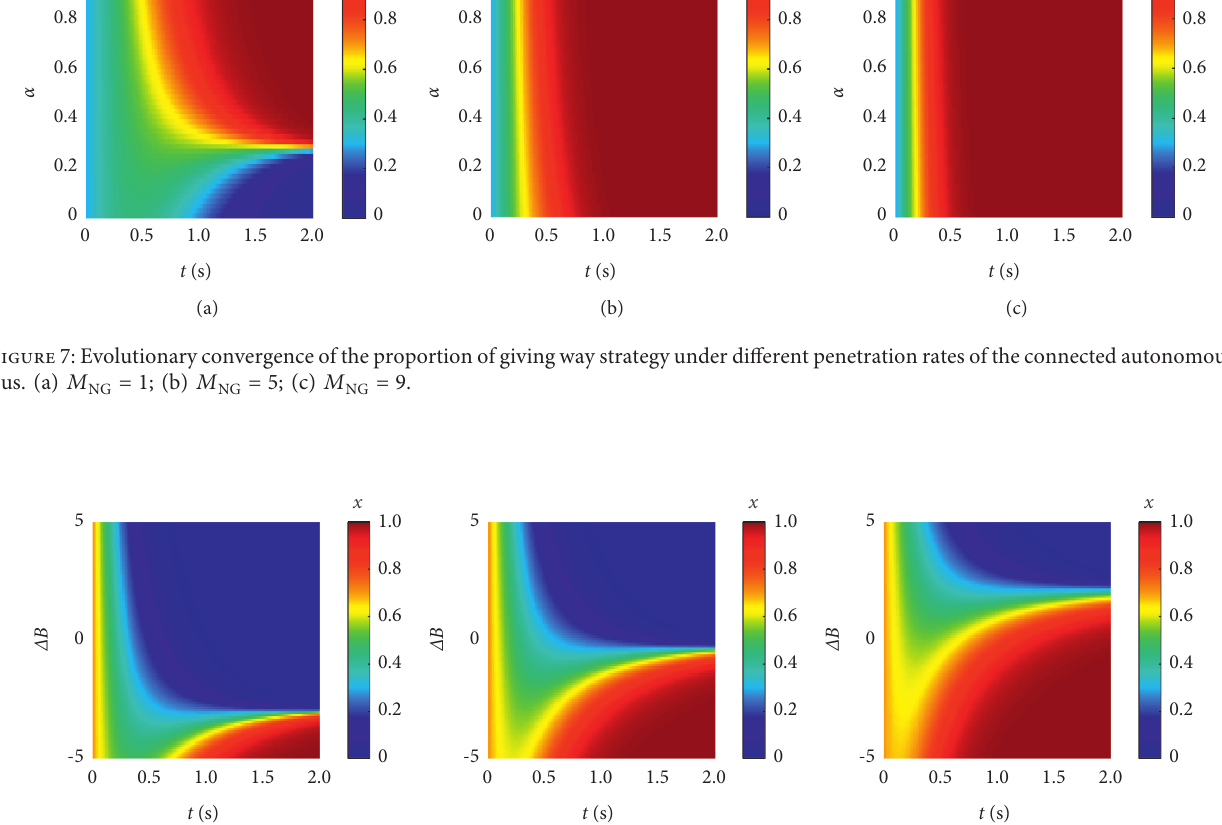
� 0; (b) M � 4; (c) M � 8. C C C